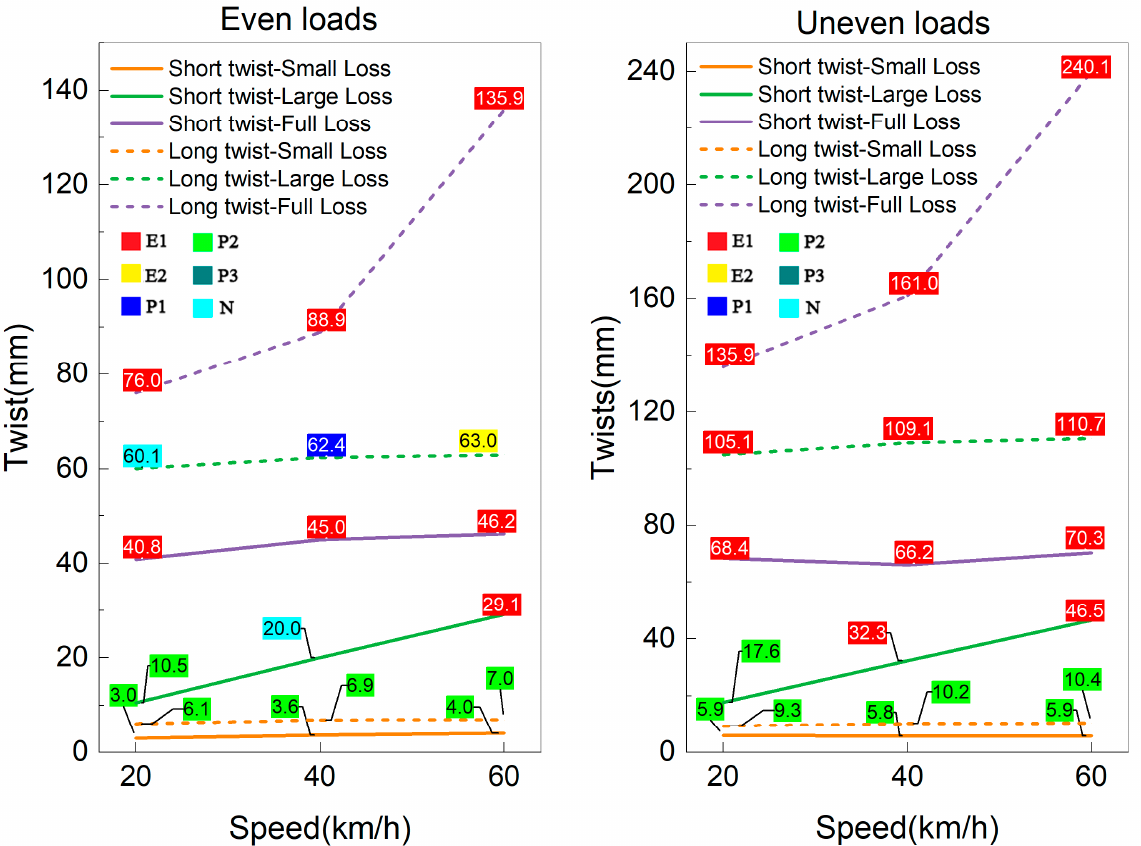
Figure 12. Dynamic twists of 1in4 interspersed tracks under different track support and load conditions. The dynamic twists for 1in2, 1in3 and 1in4 interspersed tracks exposed to